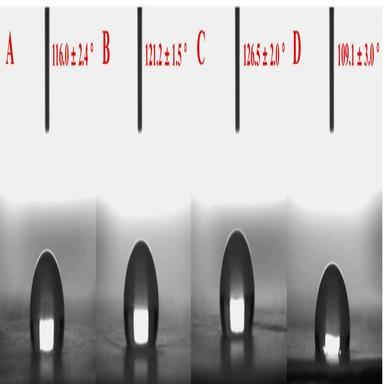
The water contact angles of the P/E-CA composite nanofiber films: (A) P/E-CA0; (B) P/E-CA2; (C) P/E-CA4; (D) P/E-CA8 (the equilibrium time was 3 s).